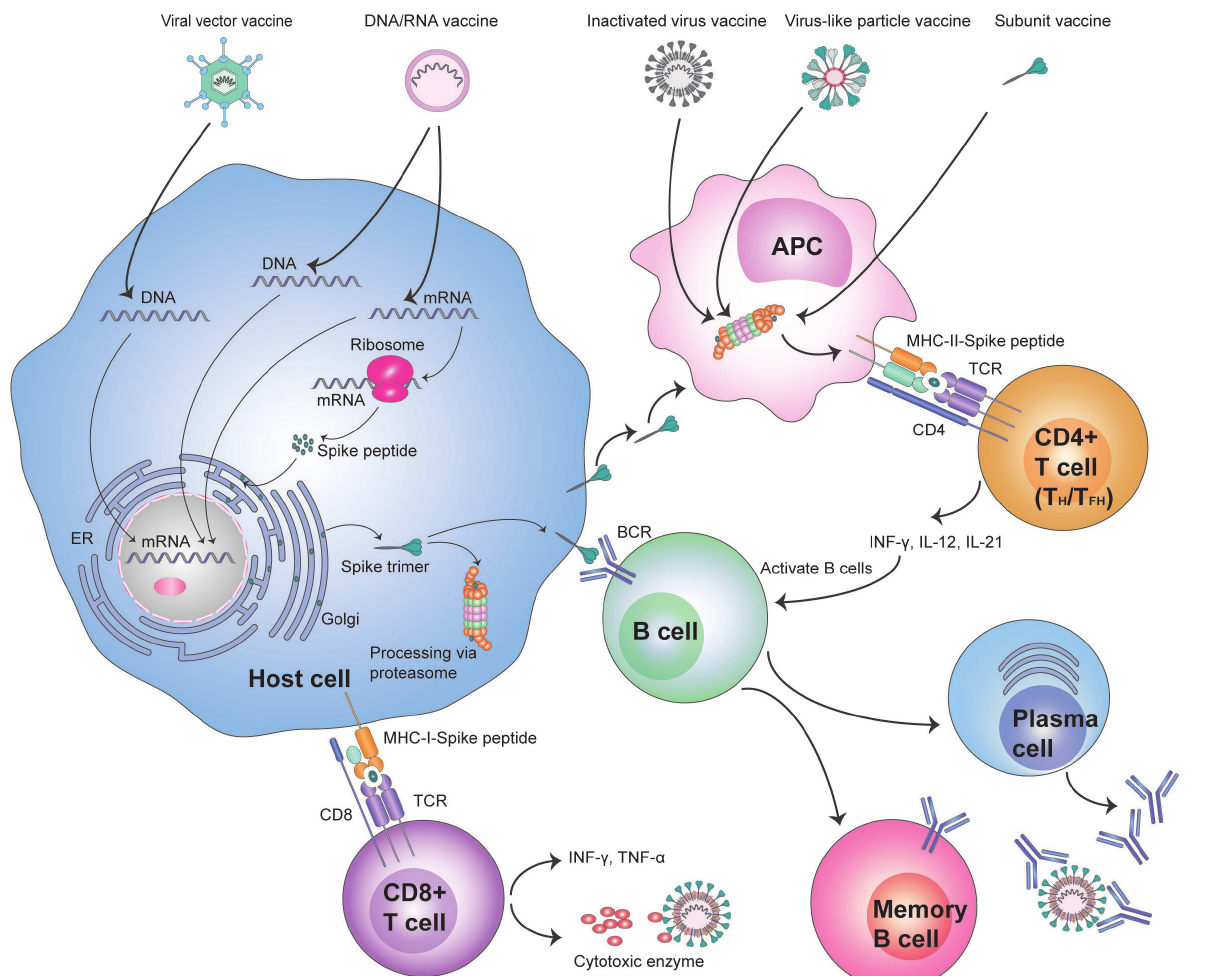
Figure 1. Diagrammatic view of COVID-19 vaccine recognition by host cells and activation of innate and adaptive immunity. ER: endoplasmic reticulum; APC: antigen presenting cell; TCR: T-cell receptor; INF-γ: interferon gamma; IL-12: interleukin 12; BCR: B-cell receptor; TNF-α: tumour necrosis factor